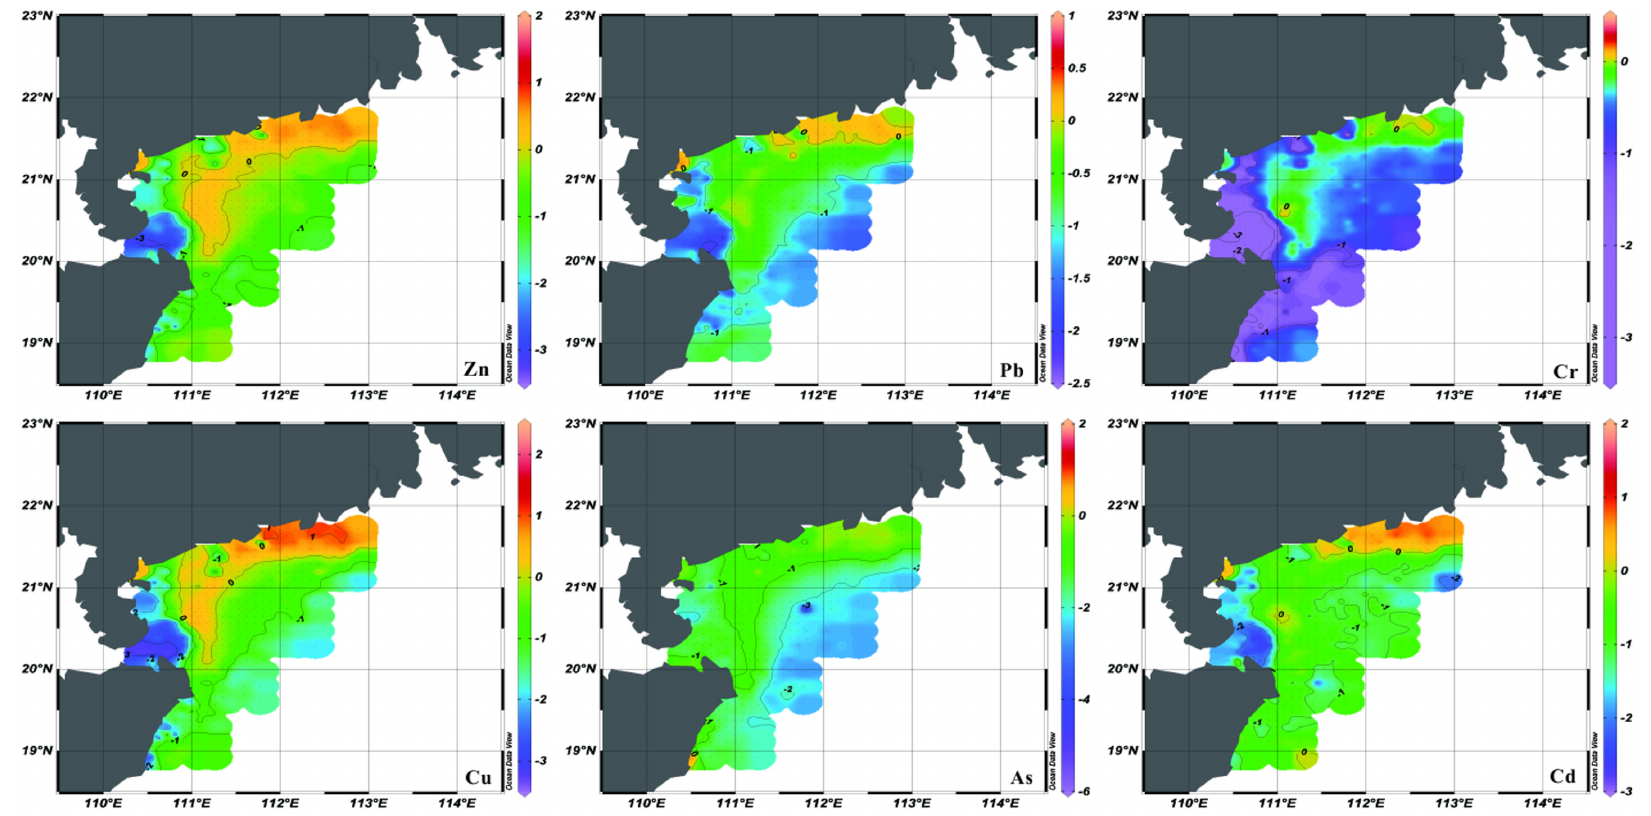
Figure 3. Spatial distribution pattern of index of geo-accumulation ( I geo ) for heavy metals in the study